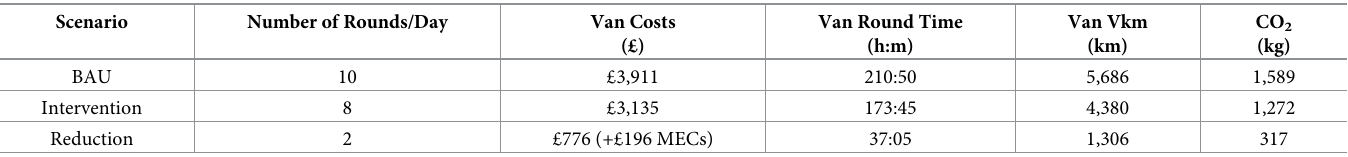
Van Round Time Van Vkm CO 2 (£) (h:m) (km) (kg)